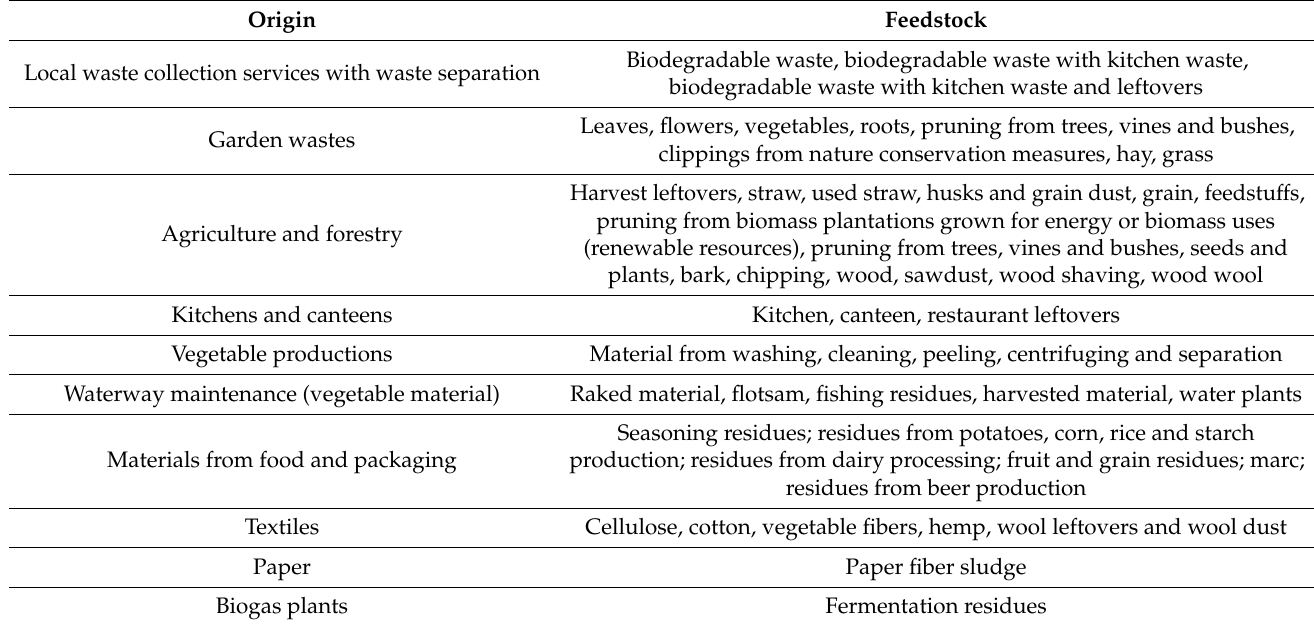
Table 1. Types of biomasses to be used for the production of biochar according to the European Biochar Certificate [48]. Origin Feedstock Local waste collection services with waste